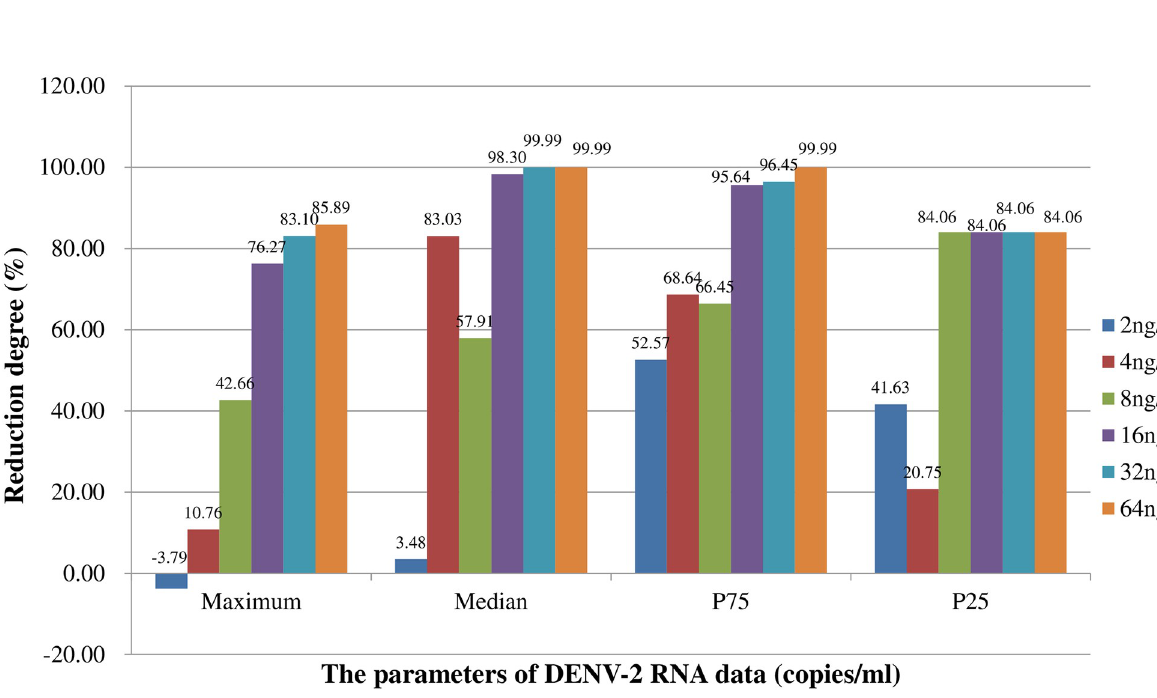
Fig 2. The correlation regression between infection rates and log 2 values of ivermectin concentrations.